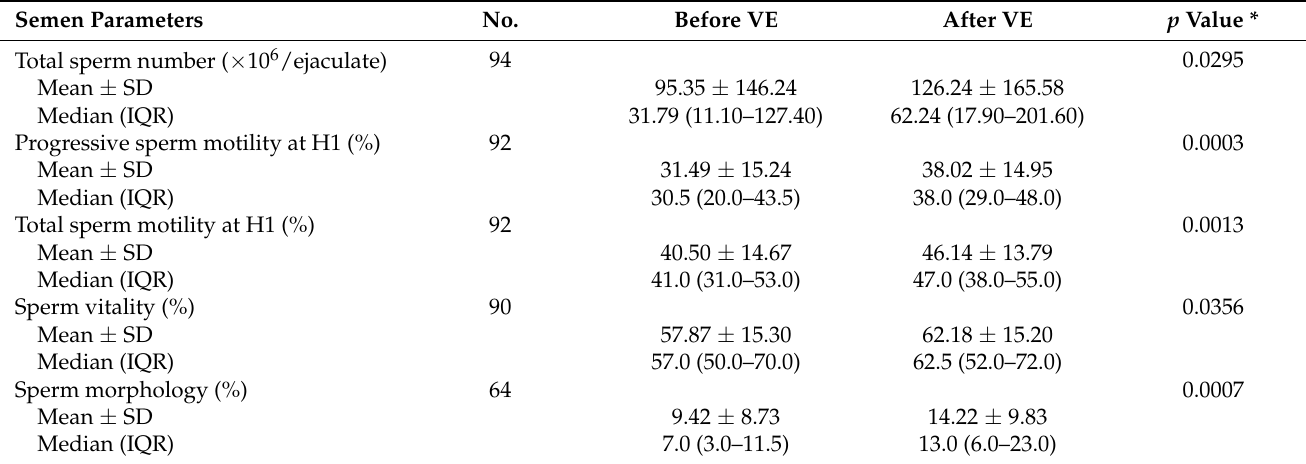
Table 2. Comparison of semen parameters before and after varicocele embolization (VE) with Glubran ® 2. Semen Parameters